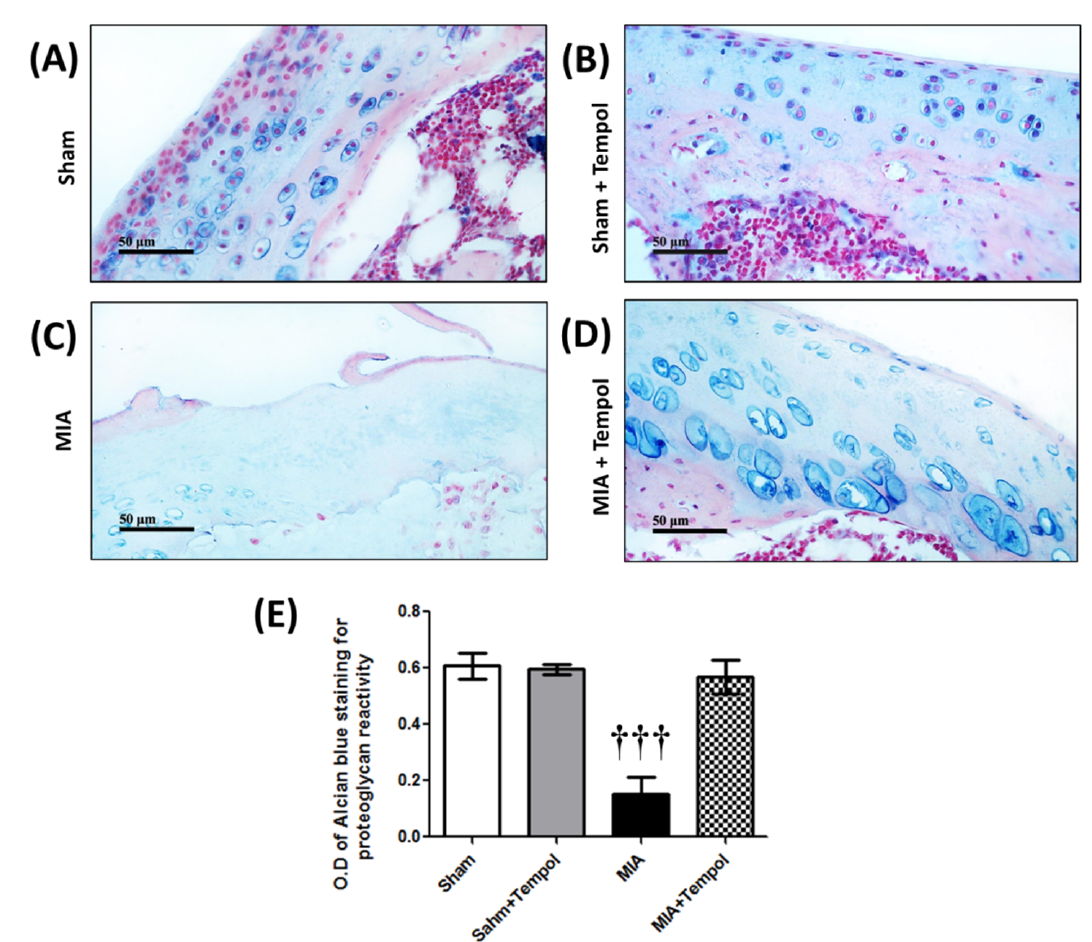
Figure 9. Effect of Tempol on representative alcian blue histochemical photomicrographs. Higher proteoglycans reactivity to alcian blue staining was also observed in ( A , B ). The MIA group demonstrated severe loss of proteoglycans reactivity to alcian blue staining all over the articular surfaces ( C ). Post-treatment with tempol ( D ) retained the higher proteoglycan reactivity. Moreover, the histogram panel ( E ) represents the analysis of optical density (O. D) of the alcian blue staining among the studied groups. Where the statistical analysis was carried out using one-way ANOVA followed by Tukey’s multiple comparison test. Results are expressed as mean ± SD ( n = 3). ††† p < 0.001 vs. the sham group.